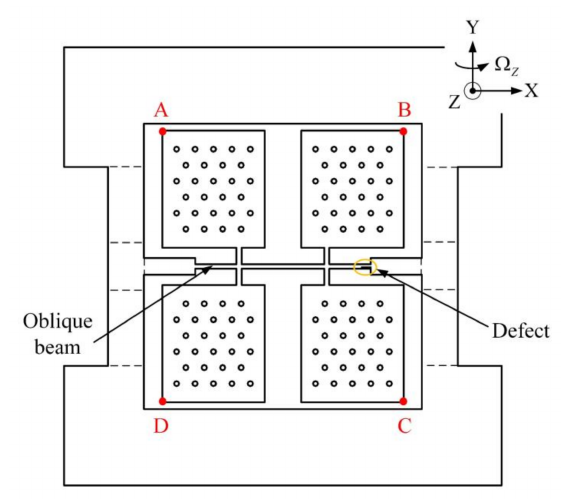
Figure 15. The sensitive structure of the BFVG: he four points with maximum amplitude are defined as A, B, C, D, and a fabrication defect is set near the anchor on the right side; the size of the fabrication defect is 50 µ m × 10 µ m × 100 µ m.